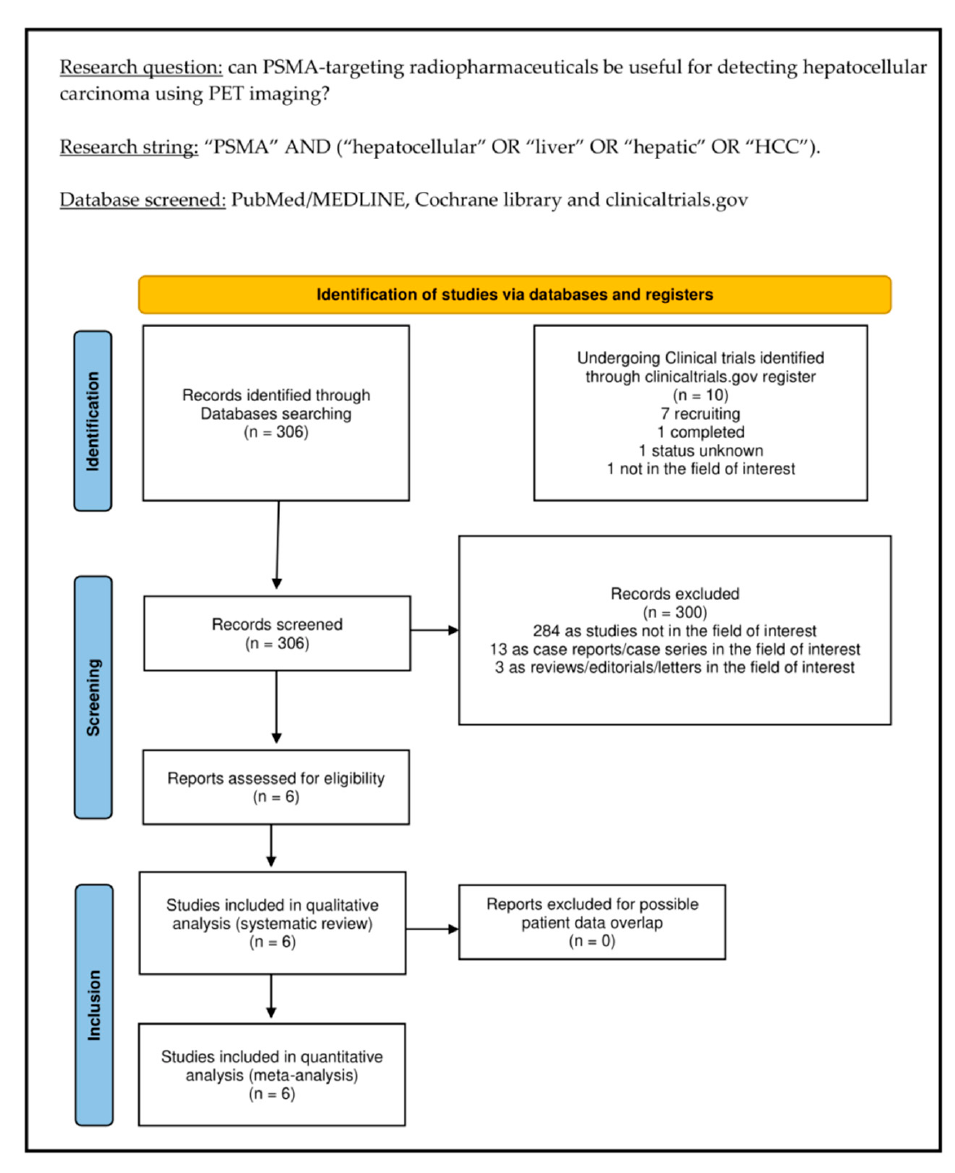
Figure 1. Summary of the study selection process for the systematic review and meta-analysis.